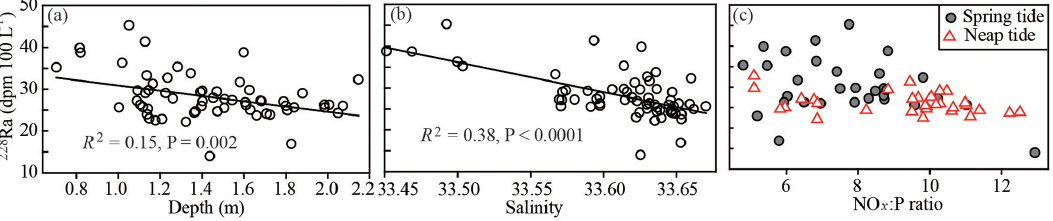
Figure 5. The activity of 228 Ra against (a) water depth, (b) salinity, and (c) the NO x :P ratio in the water column at station CT during 6–13 February 2012.